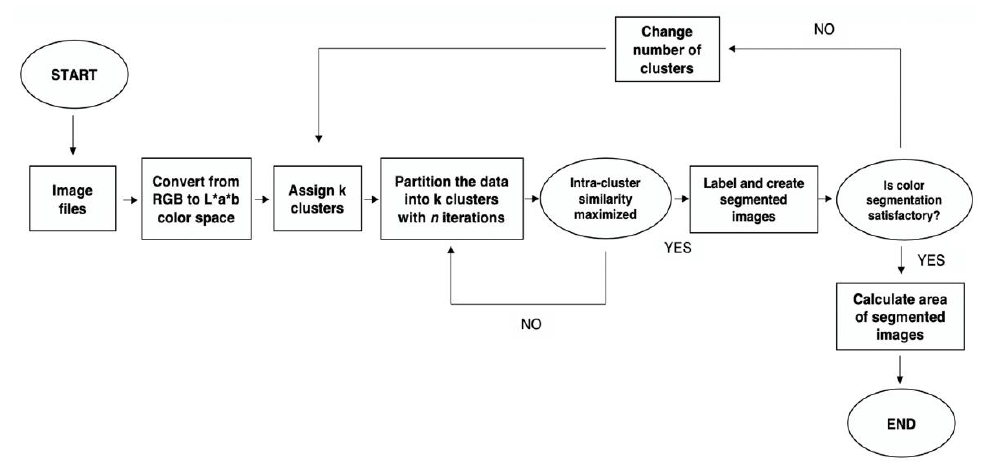
Figure 2. Block diagram of the implemented algorithm.